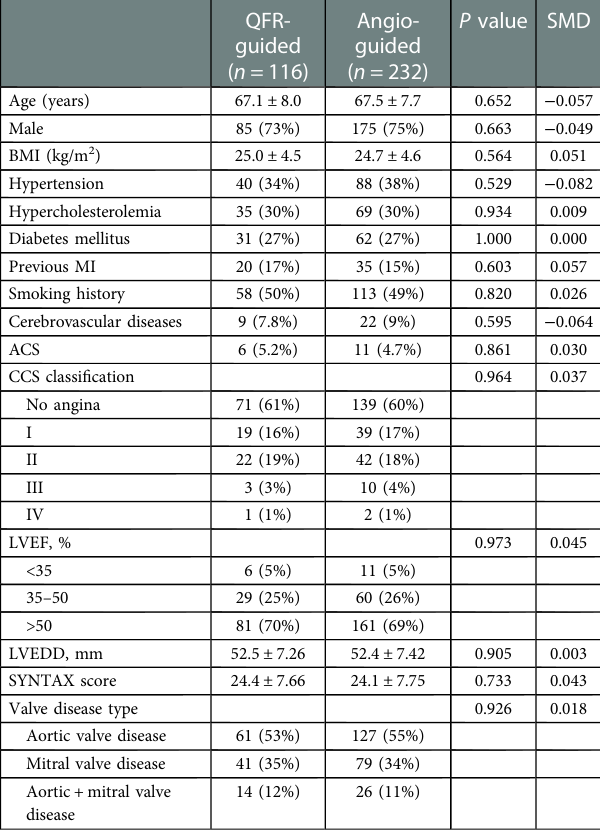
TABLE 2 Baseline characteristics of the study population